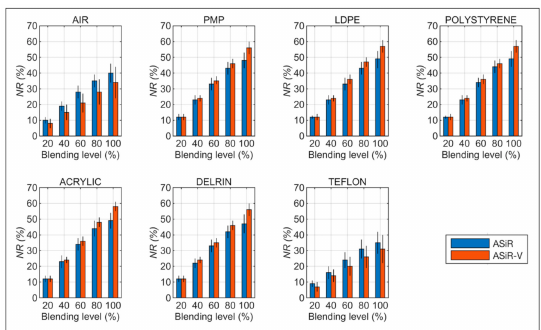
Figure 7. CTP404 phantom module with different contrast objects (i.e., air, PMP, LDPE, polystyrene, acrylic, Delrin, Teflon). Noise reduction properties of ASiR-V and ASiR reconstruction algorithms with respect to conventional FBP, NR(%) , estimated as the mean (SD) value of PDN-ASiR-V and PDN-ASiR-V maps within a central circular ROI of 1 cm diameter placed in each contrast object.